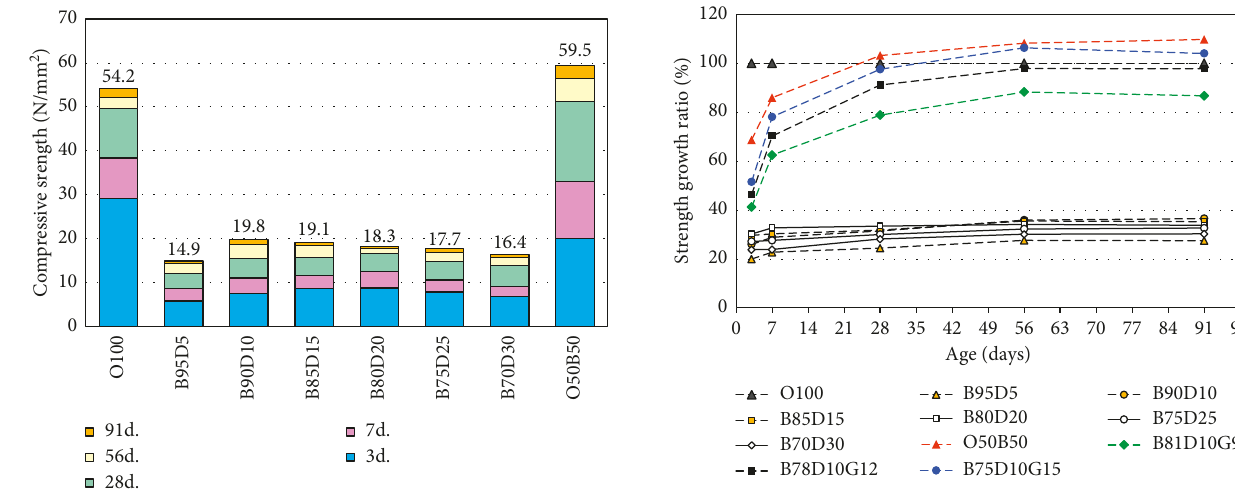
Figure 2: Compressive strength of alkali-activated mixes with BFS and DS.